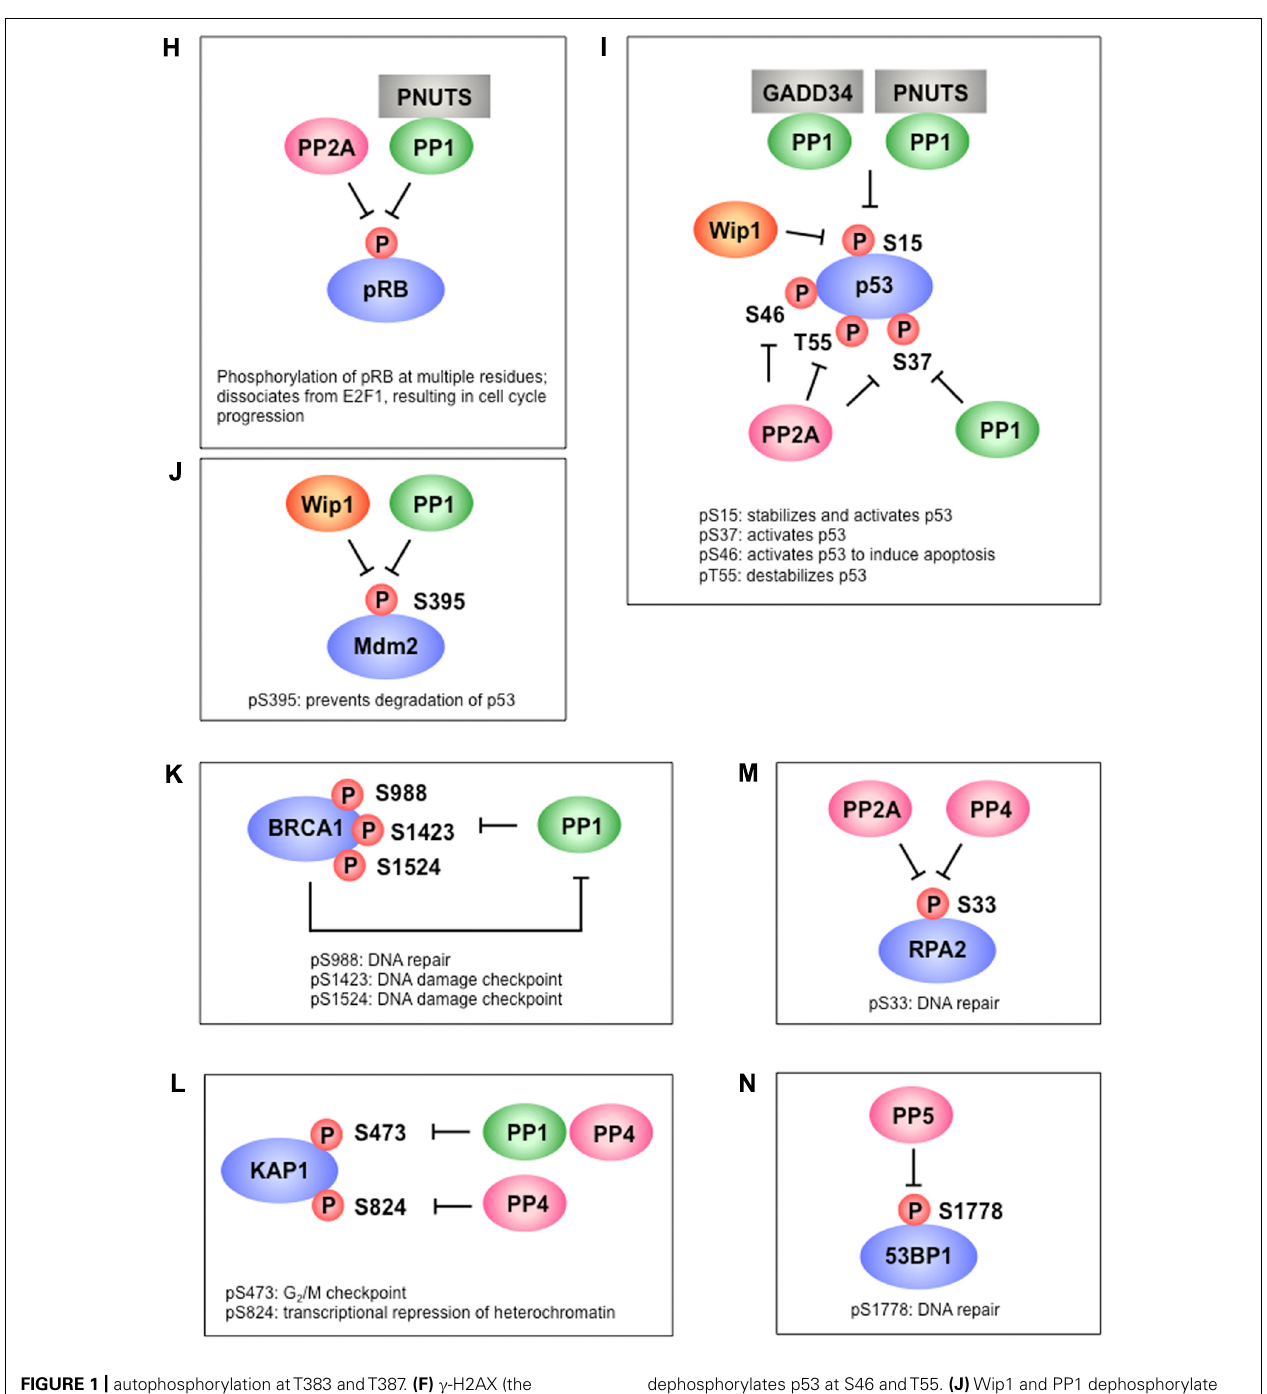
FIGURE 1 | autophosphorylation atT383 andT387. (F) γ -H2AX (the phosphorylated form of H2AX at S139) is required for recruitment of various DDR proteins to damaged sites and is dephosphorylated by PP2A, PP4, PP6, andWip1. Rvb1/Tip60 is implicated in the removal of γ -H2AX. (G) PP1 dephosphorylates H3 atT11 following DNA damage, leading to transcriptional repression of cell cycle-regulated genes. (H) PP2A and PP1-PNUTS dephosphorylate pRb at multiple sites, leading to inhibition of E2F1 activity and cell cycle arrest. (I) p53 is dephosphorylated at S15 by PP1-GADD34, PP1-PNUTS, andWip1, resulting in p53 inactivation. S37 dephosphorylation is also mediated by PP1 and PP2A. PP2A also